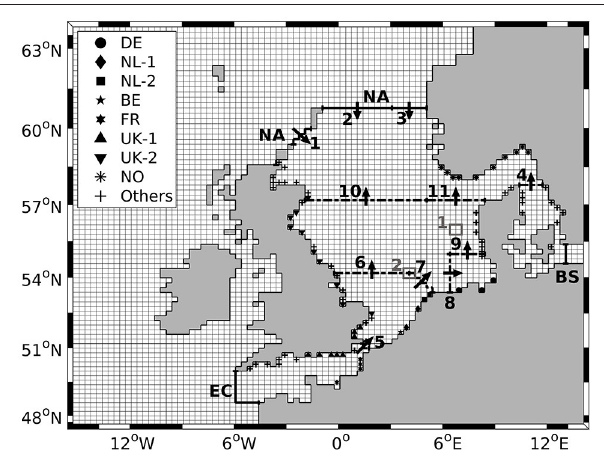
FIGURE 2 | Model domain with sub-domain used for TBNT analysis, defined by three boundaries (solid black): North Atlantic (NA), English Channel (EC) and Baltic Sea (BS). Different markers indicate river input locations for German (DE), Dutch (NL-1/NL-2), Belgian (BE), French (FR), British (UK-1/UK-2), Norwegian (NO) and other rivers (see Table 1 ). Dash-dotted lines mark sections 1 to 11 used for the validation of the volume transports simulated by HAMSOM, with arrows indicating the direction of positive net flow. Ticks mark start/end points of sections. Boxes 1 and 2 indicate regions used for time series analyses in Section 3.2.